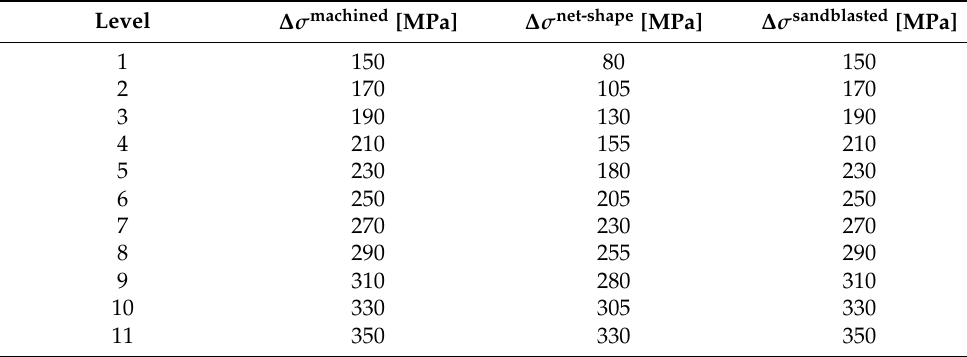
Table 6. Summary of the stress ranges adopted for the FE simulations.